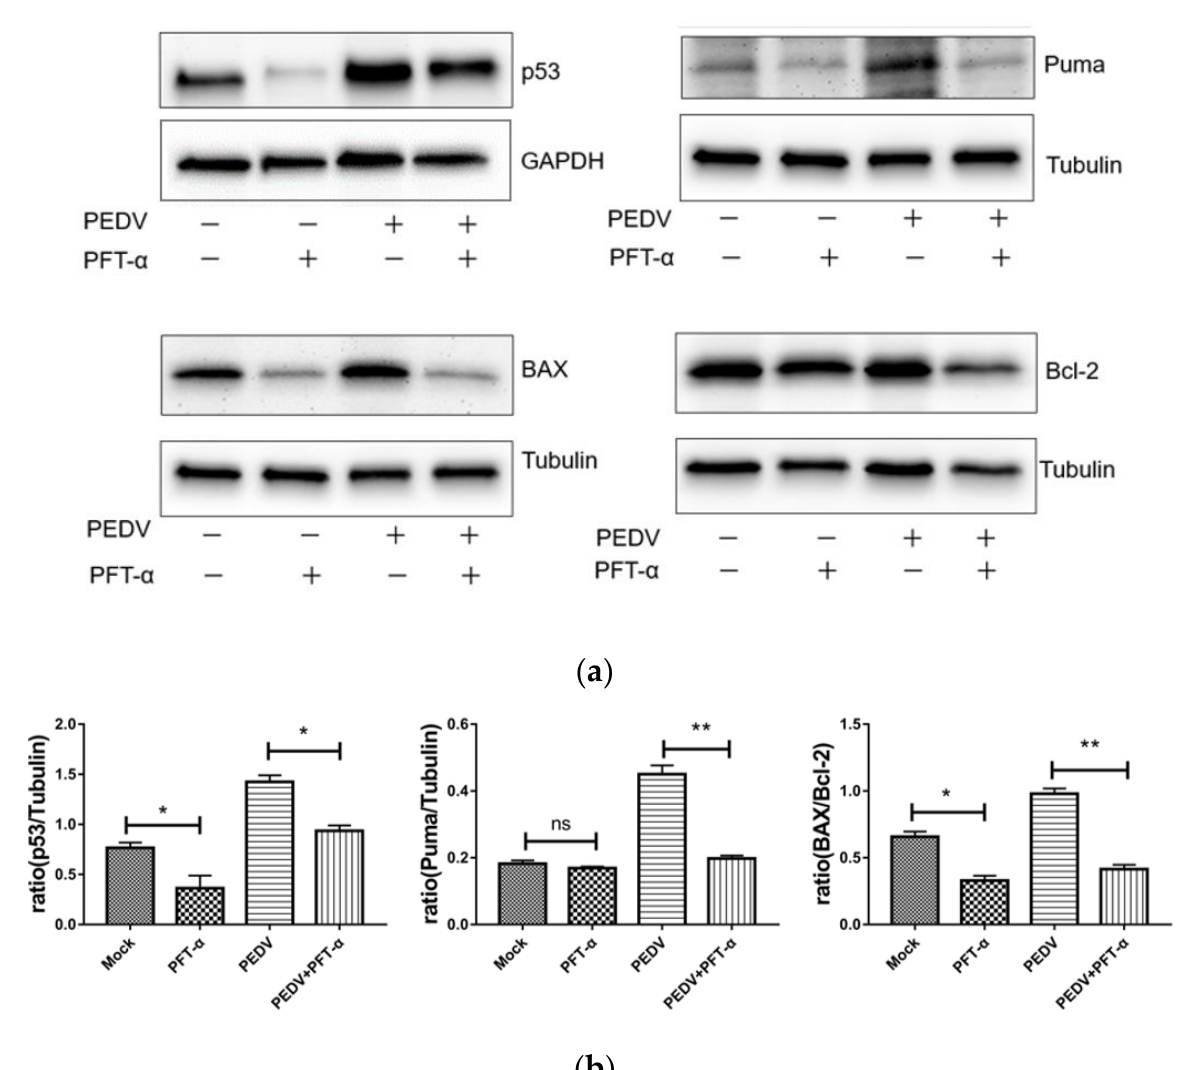
Figure 7. Effect of inhibitor PFT-α on proteins of p53, Puma, BAX, and Bcl-2 by Western blotting ( a ) and the intensity band ratio of Western blotting ( b ). ns, not significant; *, p < 0.05; **, p < 0.01. 3.10. The Inhibitor PFT- α Treatment Inhibits PEDV-Induced Apoptosis with no Effect on Cell